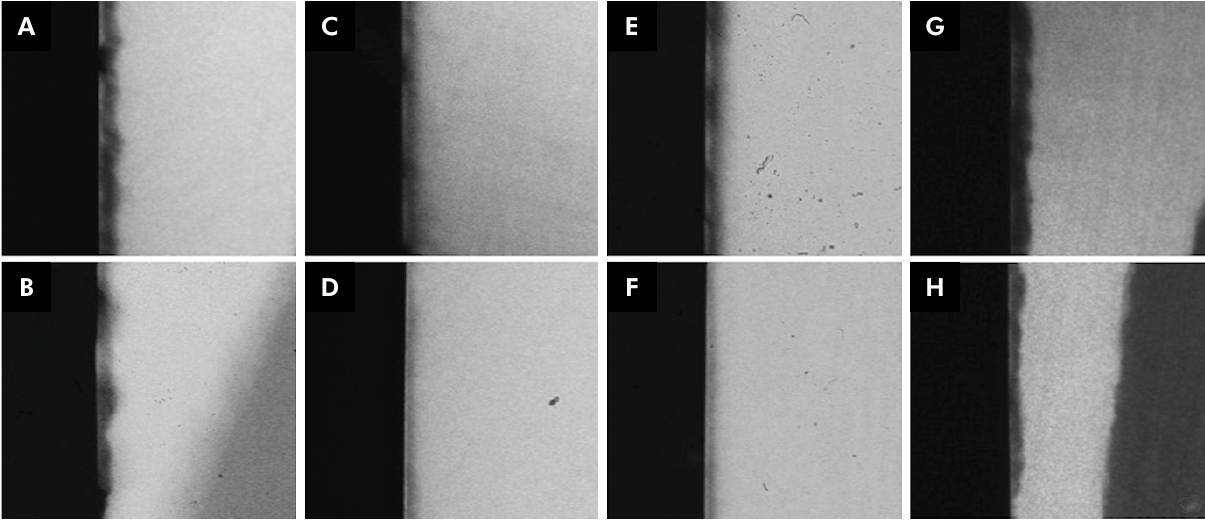
Figure 5. Microradiographs of a demineralized and re-mineralized specimen from all groups of the in situ study: A) demineralized specimen of placebo group; B) re-mineralized specimen after treatment with placebo varnish; C) demineralized specimen of 20% xylitol varnish; D) re-mineralized specimen after treatment with 20% xylitol varnish; E) demineralized specimen of 20% milled xylitol varnish; F) re-mineralized specimen after treatment with 20% milled xylitol varnish, and G) demineralized specimen of Duraphat group; H) re-mineralized specimen after treatment with Duraphat